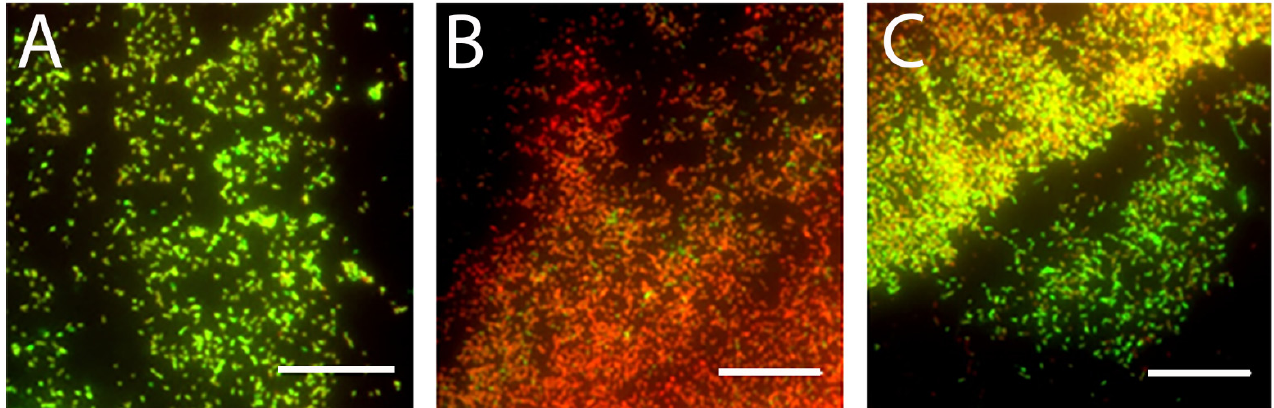
Figure 1. Representative images from live/dead staining of untreated and treated E. coli biofilms. ( A ) Biofilms grown overnight. ( B ) Biofilms treated with 16.5 µ M MAG2 for 30 min. ( C ) Biofilms treated with 16.5 µ M MAG2 for 24 h. The scale bar is 50 µ m. Cells that appear green are stained with SYTO 9, a membrane permeable dye that enters all cells, while cells that appear red are stained with propidium iodide, a membrane impermeable dye that can only access cells once the bacterial membranes have lost